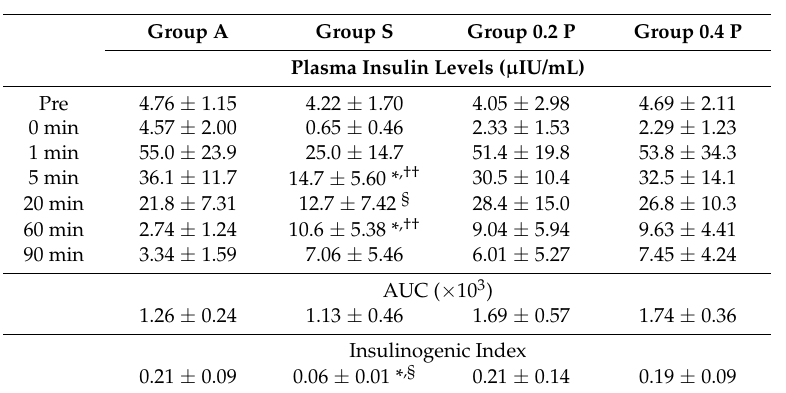
Table 2. Changes in insulin concentrations after the glucose challenge, the area under the curve (AUC) and insulinogenic index (IGI). Pre (before anesthesia induction): each time point indicates the elapsed time after the glucose challenge; 0 min means just before the glucose injection. Data are expressed as mean ± SD.